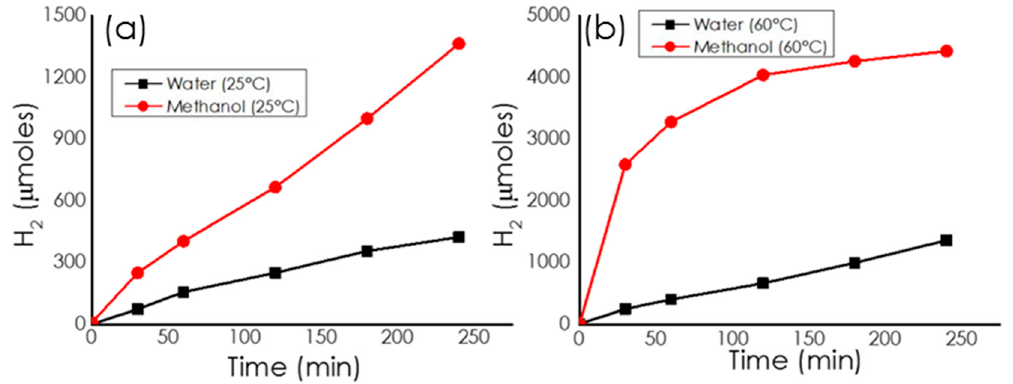
Figure 9. Temporal profiles of H 2 generation from NH 4 HCO 2 catalyzed by Pd/CS-GO2 in ( a ) methanol or water and ( b ) in methanol at 25 or 60 °C.